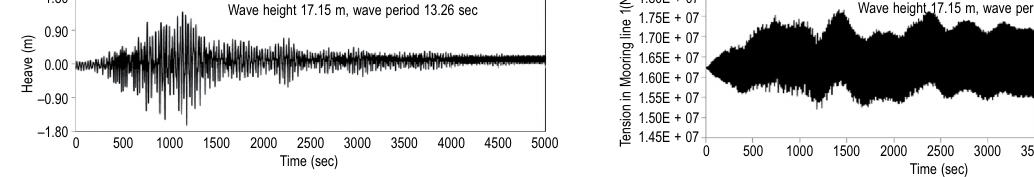
Fig. 8. Maximum tension in mooring line 1